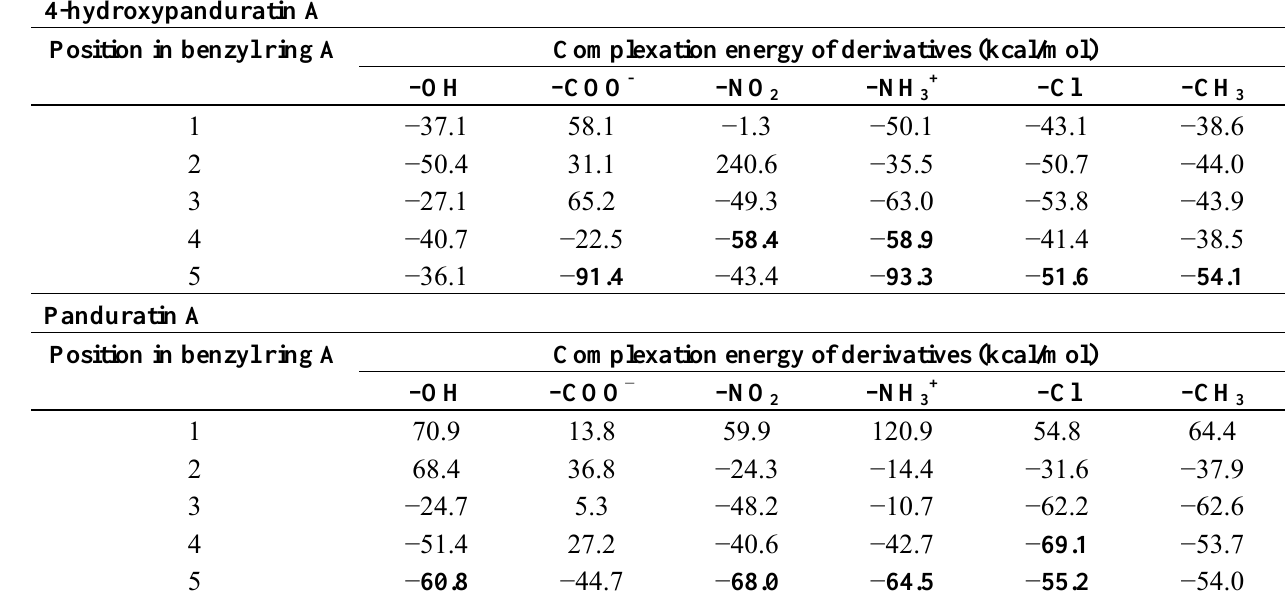
Table 2. Complexation energies of some potential inhibitor